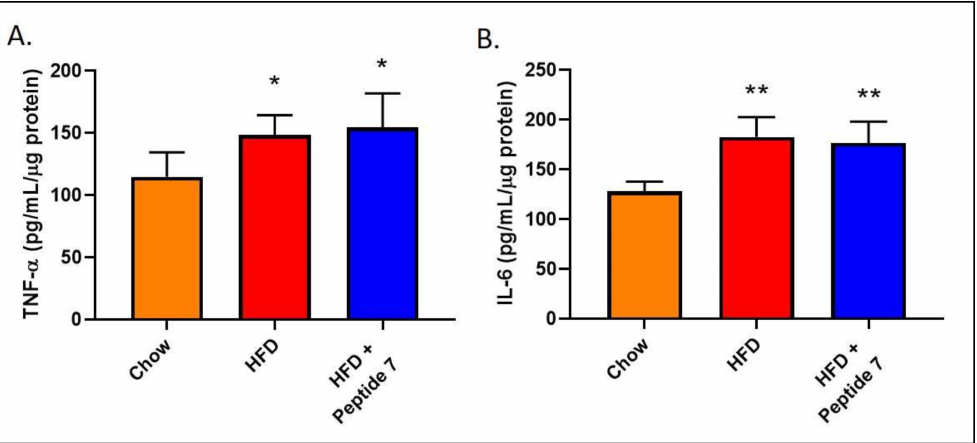
Figure 9. Peptide 7 does not reduce High Fat Diet-induced TNF- α ( A ) and IL-6 ( B ) in the liver. * p = 0.03, ** p = 0.002 when compared with mice on a chow diet, n = 4–5 mice/group with mean ± SD.